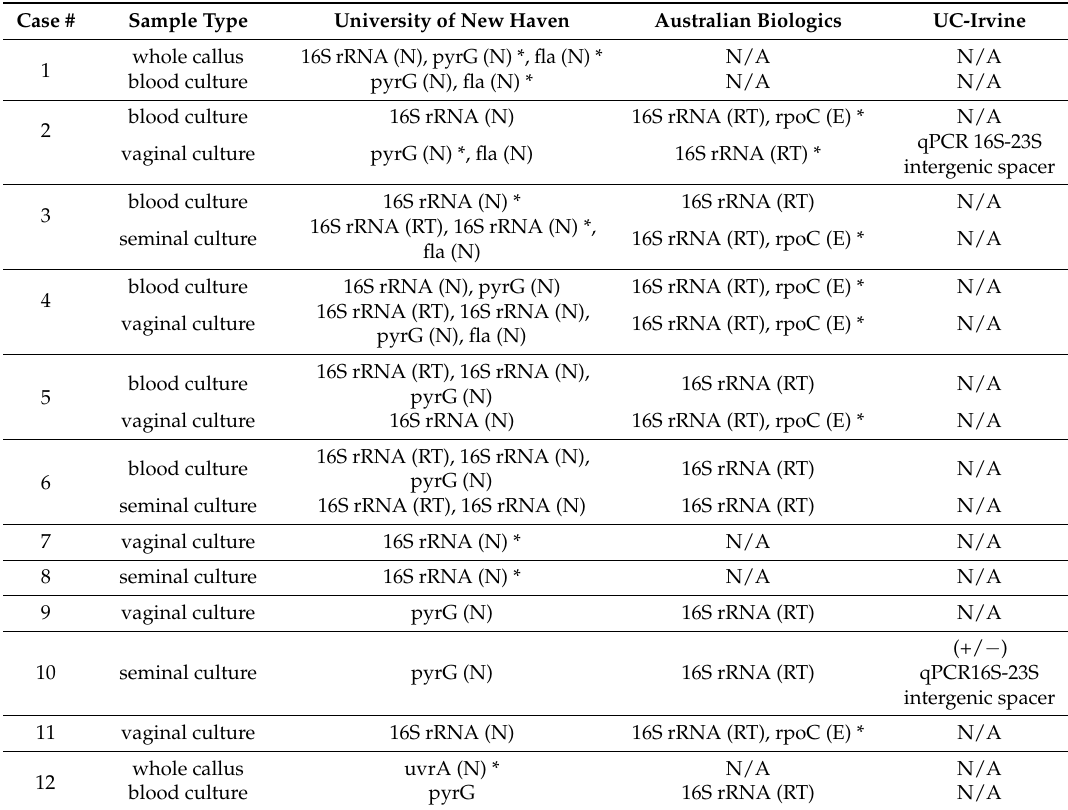
Table 4. Summary of PCR Results from Patient Culture